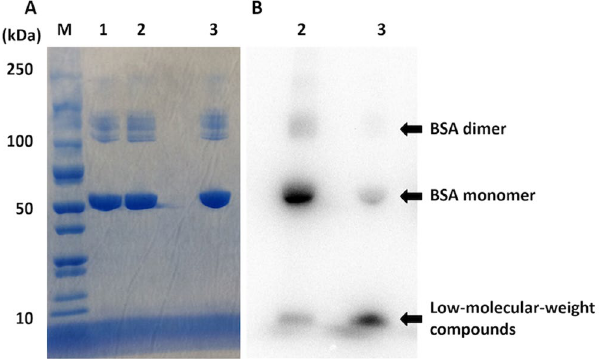
Figure 10. Analysis of [ 125 I] 4 -BSA by SDS-PAGE. Left and right panels show CBB staining ( A ) and autoradiography ( B ), respectively. BSA (8 ng) only (lane 1, CBB staining), [ 125 I] 4 -BSA (8 ng) (lane 2, CBB staining and autoradiography), and the reaction mixture of [ 125 I] 2 and BSA (8 ng) (lane 3, CBB staining and autoradiography) were subjected to SDS-PAGE, respectively. Lane M shows molecular weight markers. Images were cropped to remove extraneous